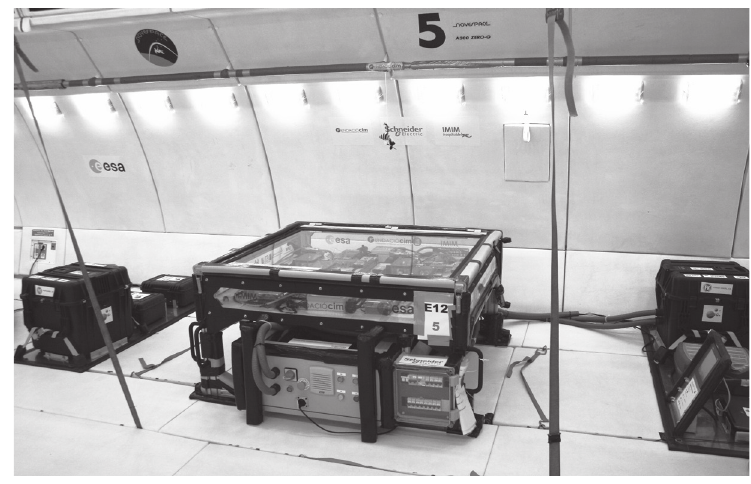
Figure 2. Final prototype configuration. This picture shows the final configuration of the experiment on board the parabolic aircraft. The three racks presented were, from left to right: storage rack, main rack, fluids and control rack. All principal electric components were placed in a sealed fire-proof cabinet underneath the main rack to protect the equipment from water contact in case of failure of the containment system. per each specific group of samples. Accurate fluid